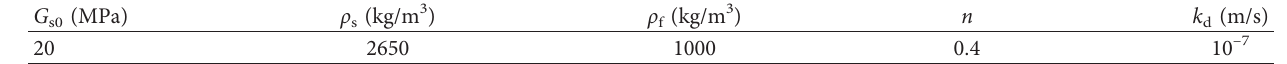
Table 1: Calculation parameters of the saturated soil.